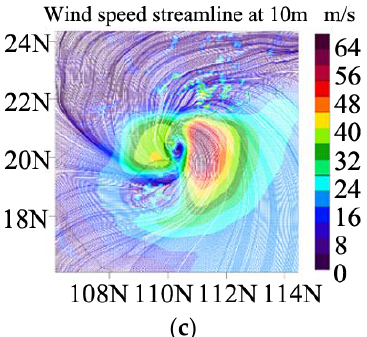
Figure 6. Streamline diagrams at different landing stages. ( a ) Before landing. ( b ) On landing. ( c ) After landing.